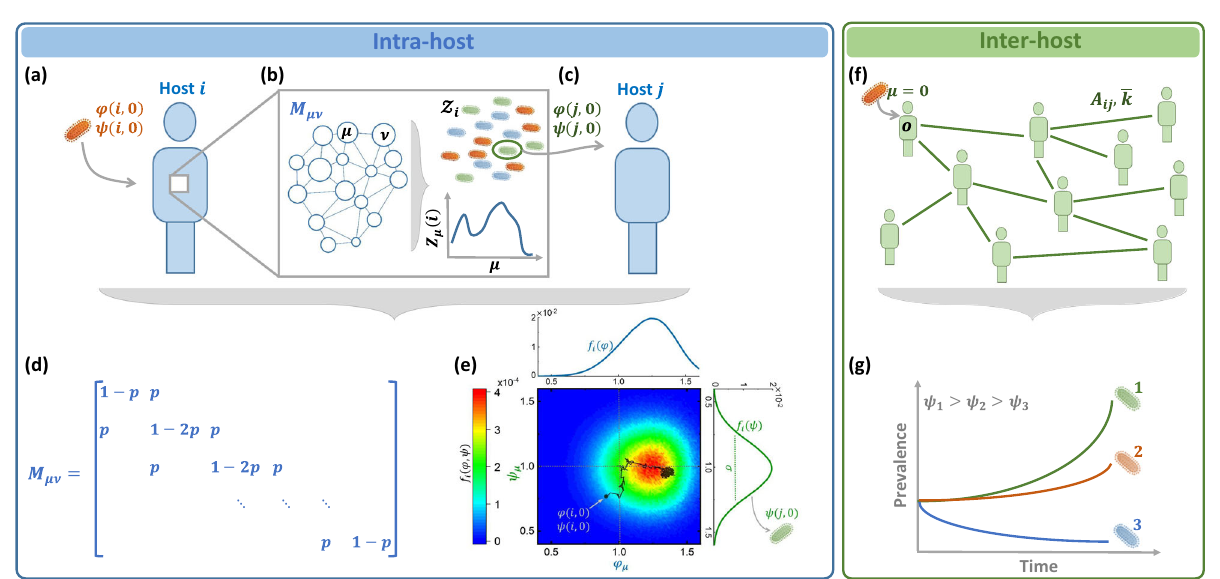
Fig. 1 | The interplay between evolutionary and epidemiological dynamics. a Host i contracts a pathogen (orange) with initial fi tness φ ( i ,0), ψ ( i ,0). b Within i the pathogen replicates, undergoing mutation and selection. The potential transi- tionsbetweenstrains μ → ν isgovernedby M μν .Strainswithhigherintra-host fi tness ( φ μ ( i ))replicateatahigherrate.After ρ replicationcyclesthepathogenpopulation within i takes the form of a multistrain Z i , in which there is a fraction Z μ ( i ) of the strain μ . c Upon transmission i → j , a single (or few) individual pathogens are sam- pledfrom Z i ,instigatingagain, j 'sintra-hostdynamics,thistimestaringfrominitial fi tness φ ( j ,0), ψ ( j ,0). d The transition matrix M μν . Mutations enable transition with probability 0 ≤ p ≤ 1 between adjacent strains. The larger is p , the less stable is the pathogen. e The fi tness distribution f i ( φ , ψ ) in (1) following ρ =25,000 replication/ mutation cycles initiated at an arbitrary φ ( i ,0), ψ ( i ,0) (grey dot). Each lineage captures a random walk in fi tness space (black path), resulting in the